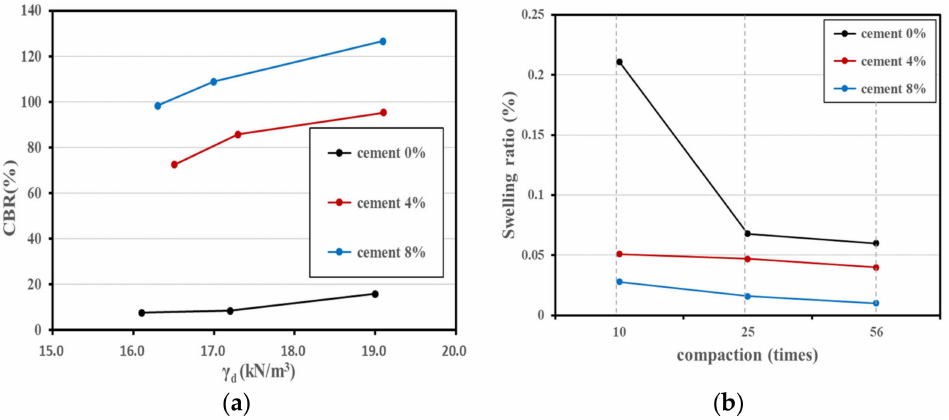
Figure 20. CBR values and swelling ratio for treated soils: ( a ) CBR versus γ d ; ( b ) Swelling ratio versus compaction